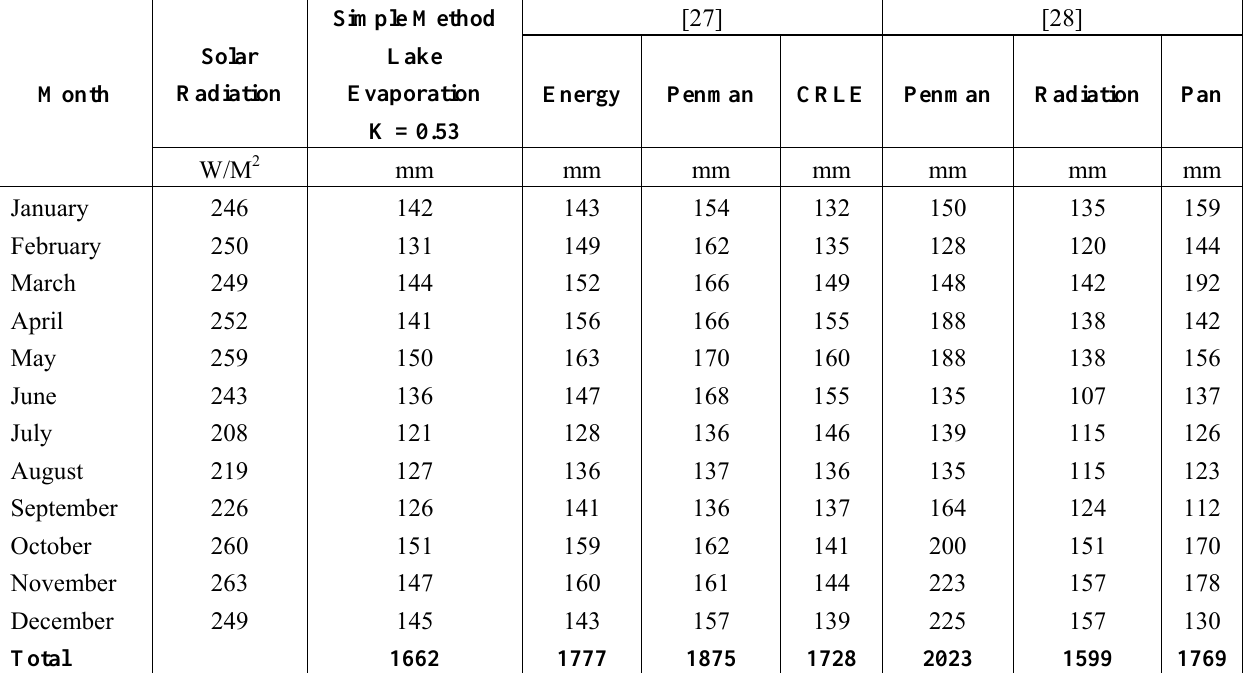
Table 2. Lake Ziway evaporation estimations with various